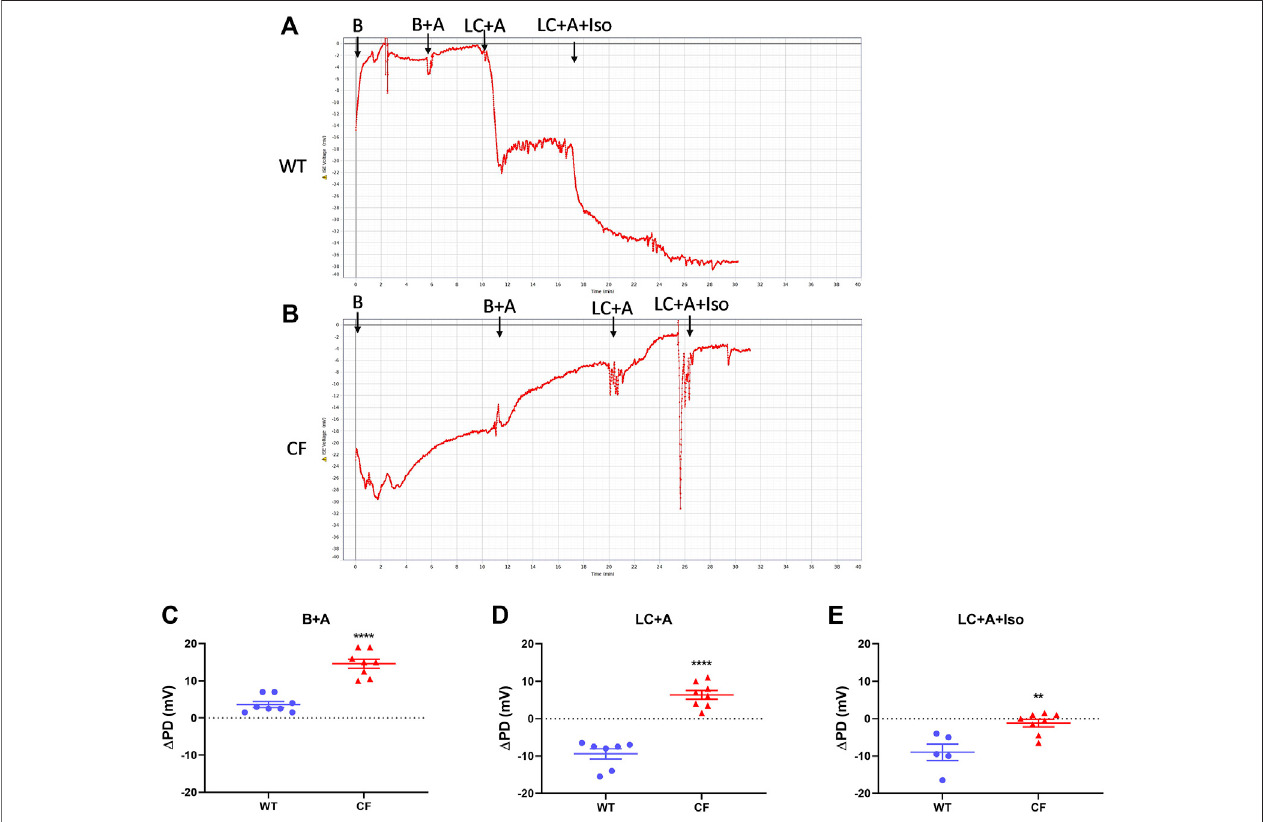
FIGURE 3 | Nasal PD trace of (A) WT and (B) CF mice following infusion of KRB basal (B), basal + amiloride (B + A), Low chloride + amiloride (LC + A) and Low chloride + amiloride + isoproterenol (LC + A + Iso). Δ PD in WT (blue circle) and CF (red triangle) mice after (C) the addition of amiloride (B + A), (D) Low chloride (LC + A) and (E) the agonist isoproterenol (LC + A + Iso) into the sequence at the 20 μ l/min infusion rate (** p < 0.01, **** p < 0.0001, t-test, mean ± SEM, n (cid:2) 5 –